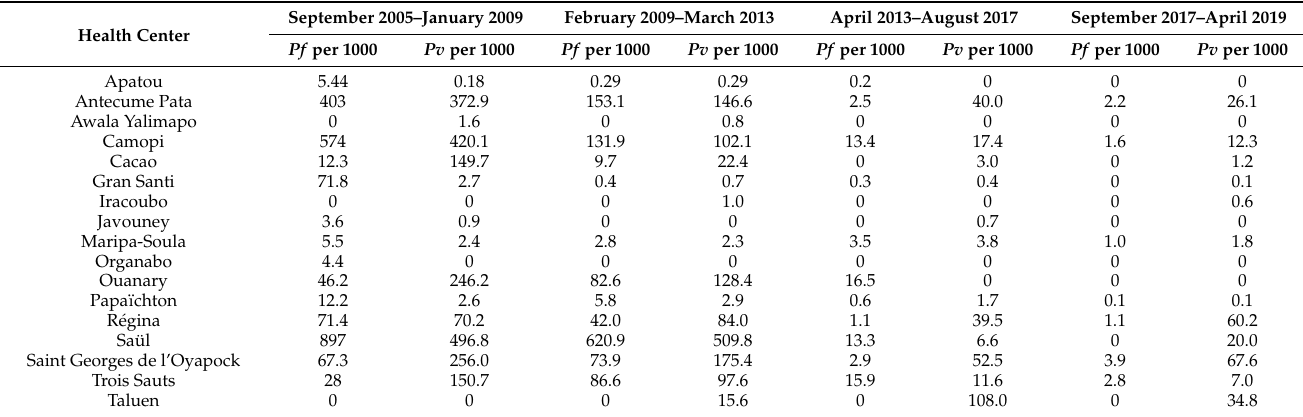
Table 1. Incidence per 1000 people for Plasmodium falciparum (Pf) and Plasmodium vivax ( Pv )at each health center during each change-point analysis transmission period. Health